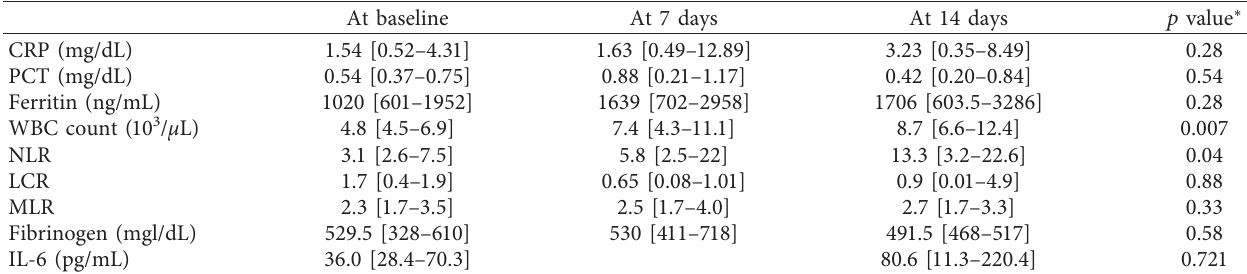
Table 3: Inflammatory parameters at baseline, 7days, and 14days after